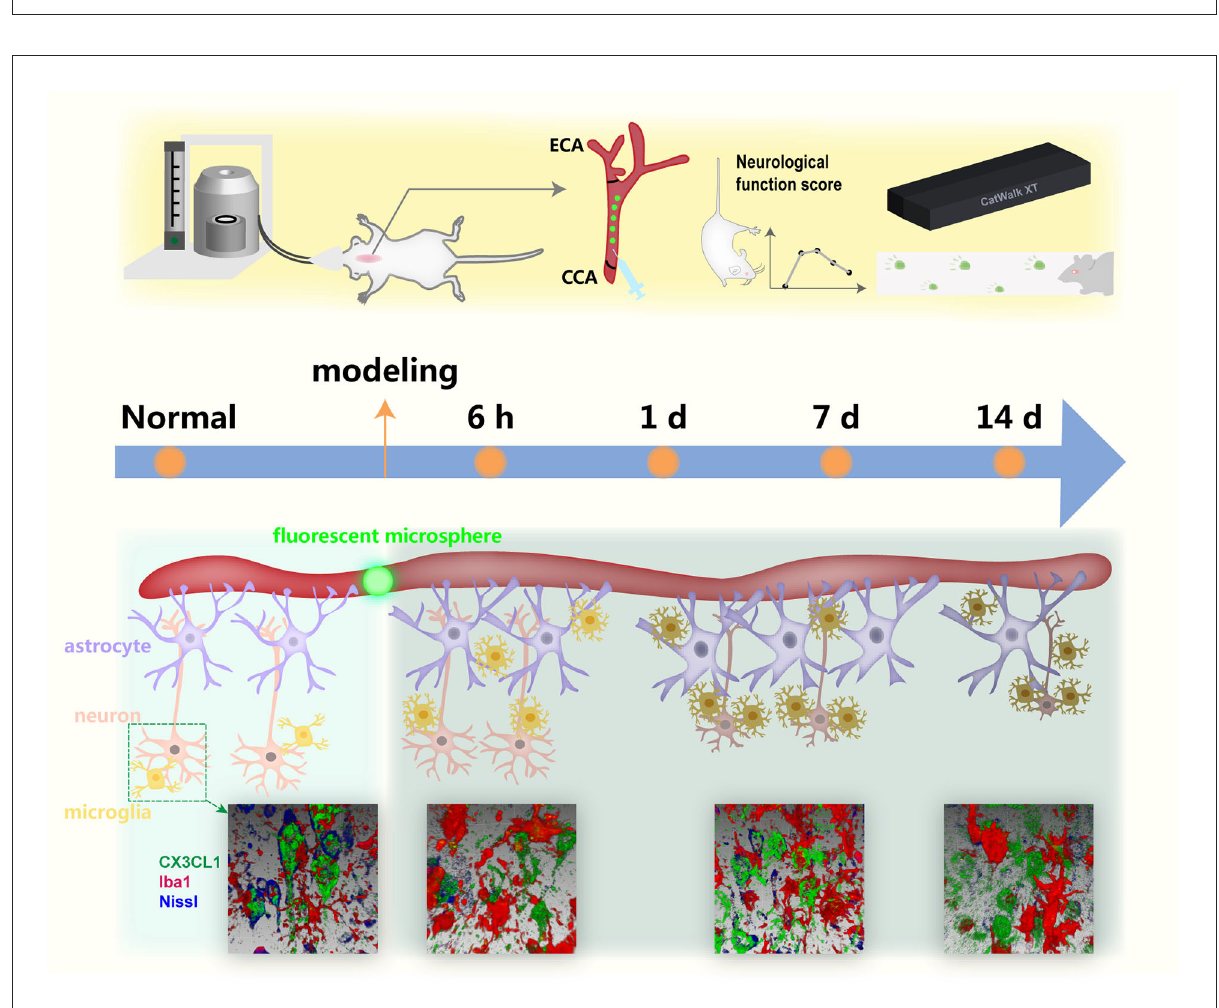
FIGURE8 A simplified illustration of the temporal alteration in the infarcted regions with lodged fluorescent microsphere in the cerebral